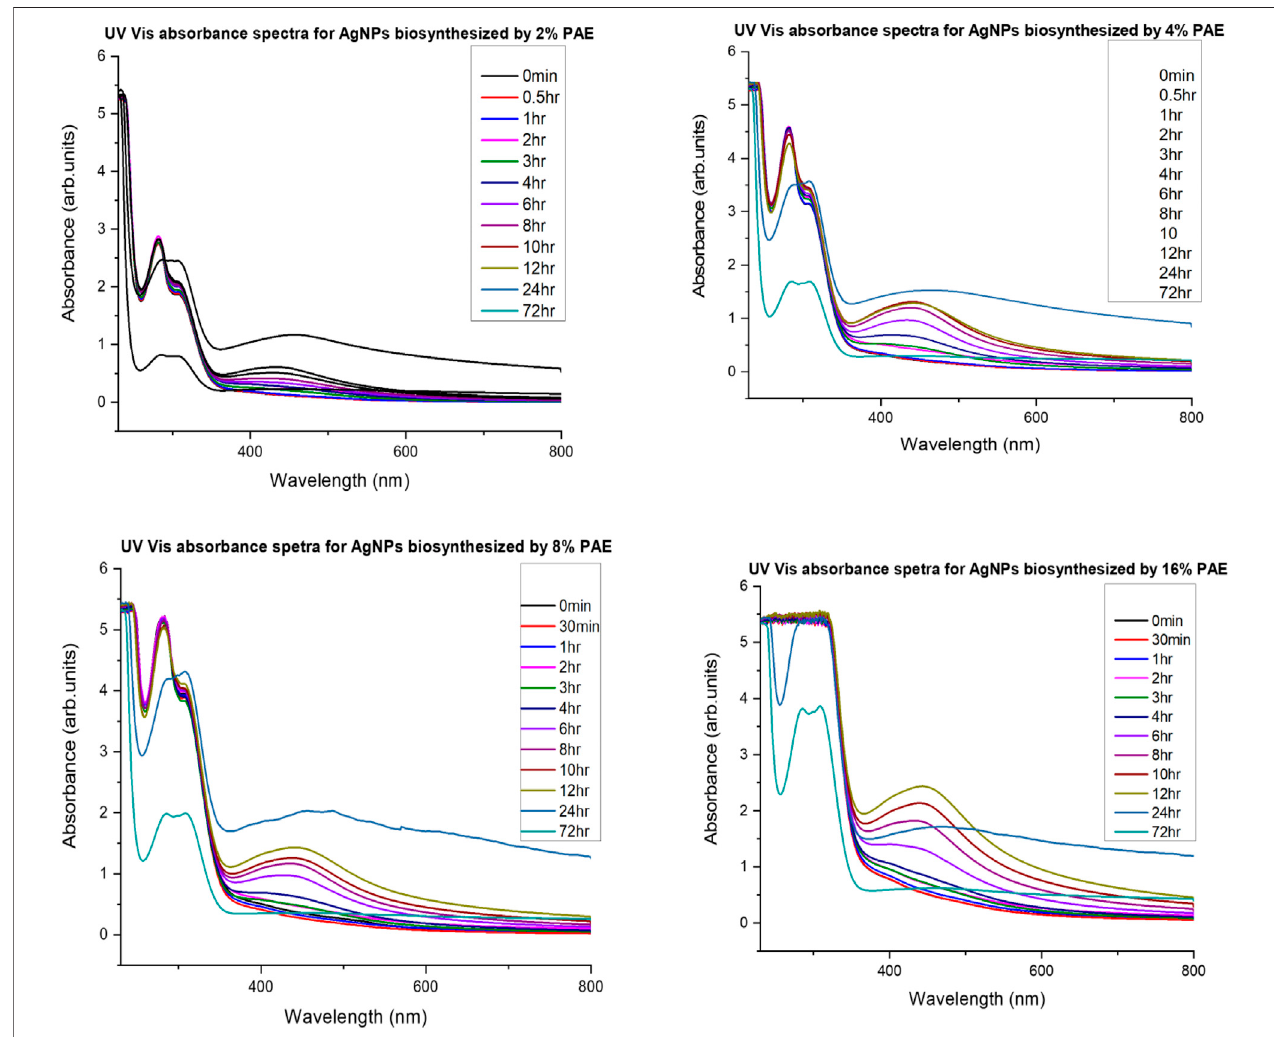
FIGURE 4 | UV-vis absorbance spectra monitoring silver nanoparticles ’ PAE-mediated biosynthesis and stability.